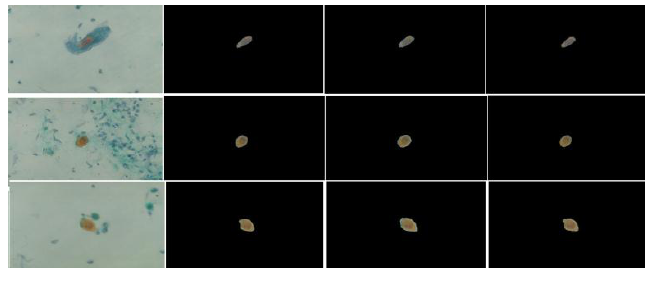
Figure 4. Samples of sputum cell extraction results. From left to right: raw images, ground truth data, cell detection with λ = 2, and cell detection with λ =